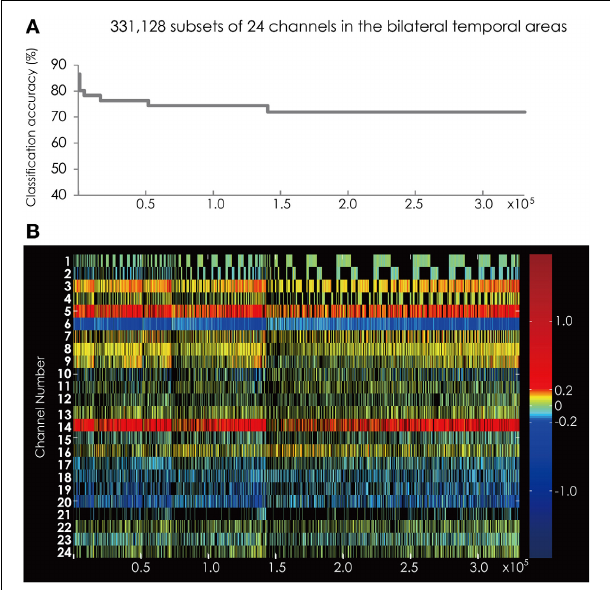
FIGURE 6 | (A) The classification accuracy corresponding with 331,128 subsets consisted from the channels in the bilateral hemisphere. (B) The channel numbers in the subsets represented in (A) .